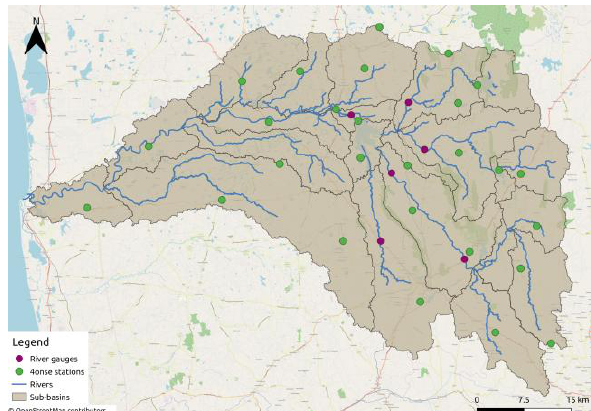
Figure 5. Locations of the 4onse stations and river gauges in